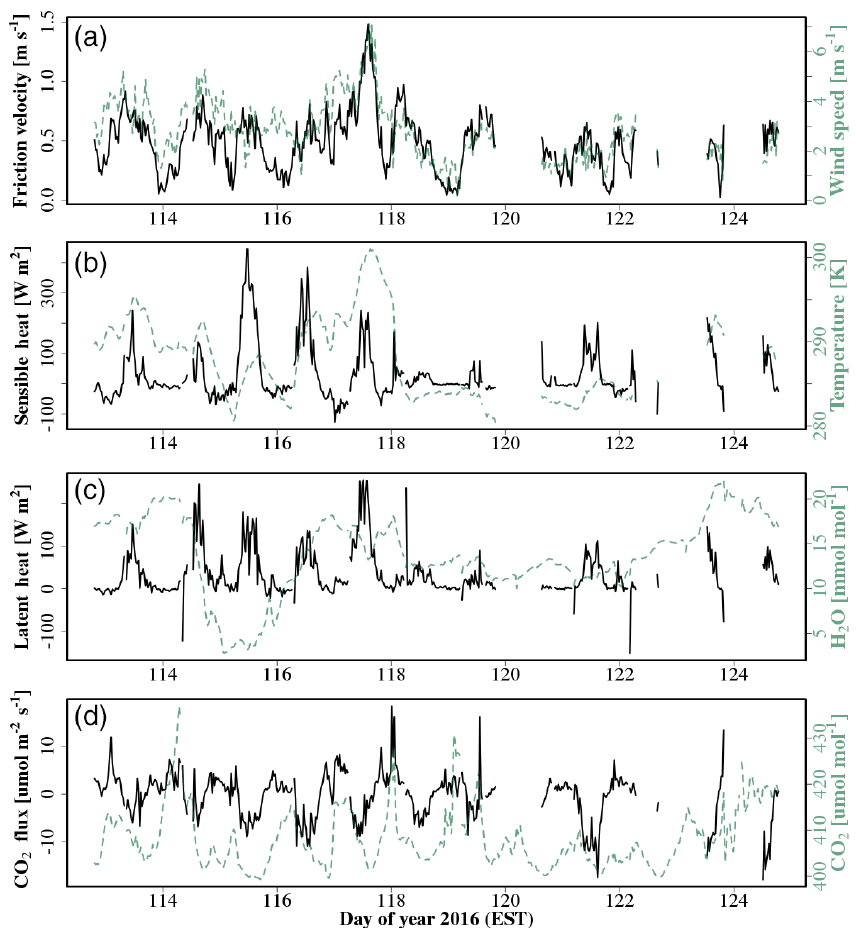
Figure 9. Time series of turbulent fluxes derived from EC measurements atop the NEON SERC tower. Panels (a) – (d) indicate vertical turbulent exchange of shear (friction velocity) and wind speed, sensible heat and temperature, latent heat and H 2 O dry mole fraction, and CO 2 flux and CO 2 dry mole